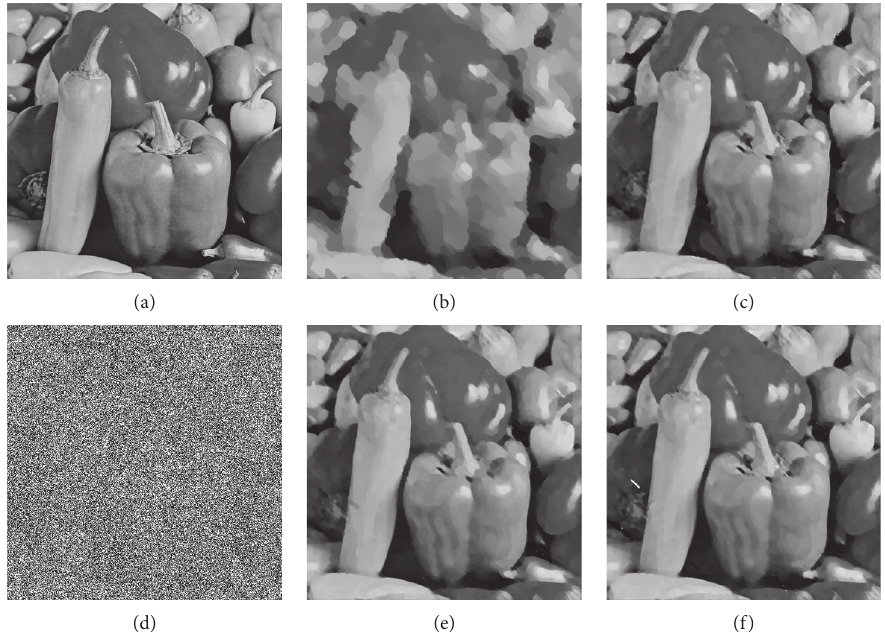
Figure 9: The recovery results (Peppers 512) by Motion blur with 90% SP noise. (a) Original. (b) TVL1, PSNR � 19.4711. (c) TVSCAD, PSNR � 25.3923. (d) Motion blur (lev � 0.9). (e) TVLog, PSNR � 25.5329. (f) LogTVSCAD, PSNR �